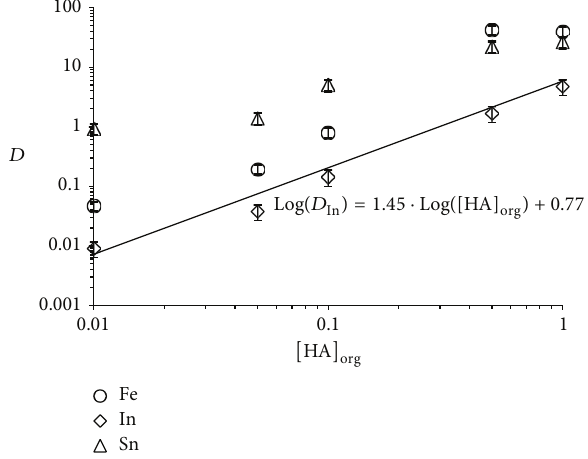
Figure 7: Effect of free D2EHPA concentration on the extraction of metals from 1M HCl at 293 ± 2 K and 𝜃 = 1 .